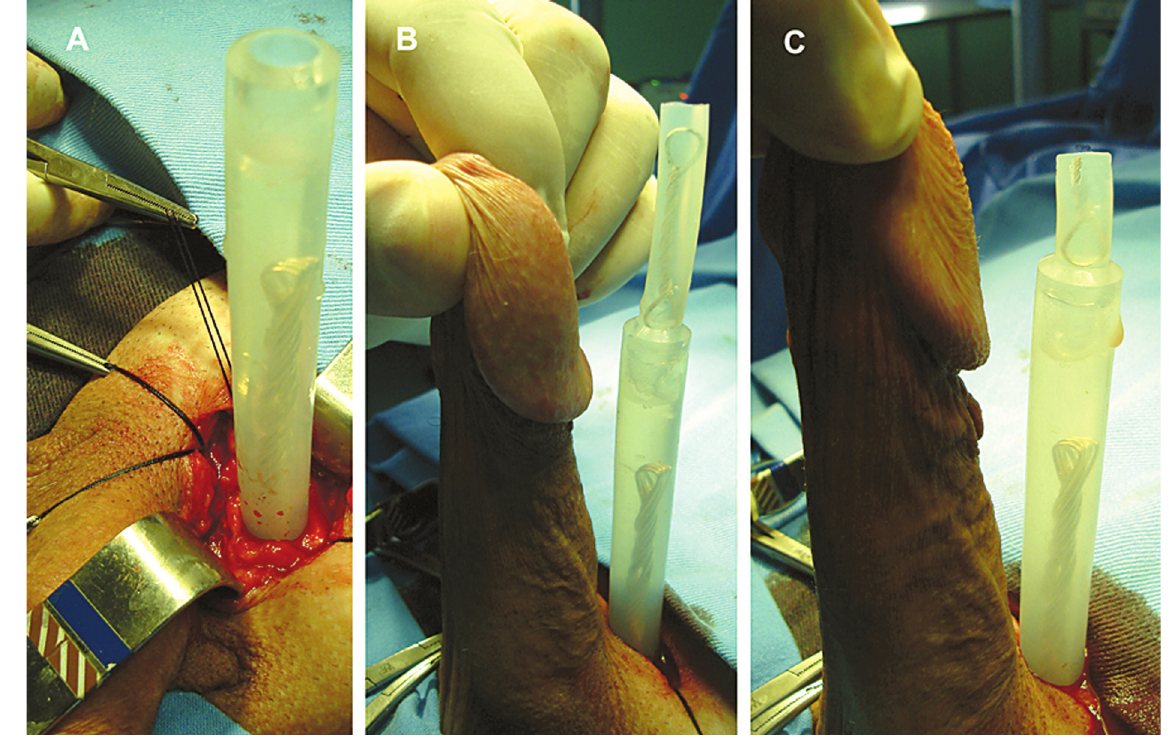
Figure 4 – Procedure to adapt the size of the